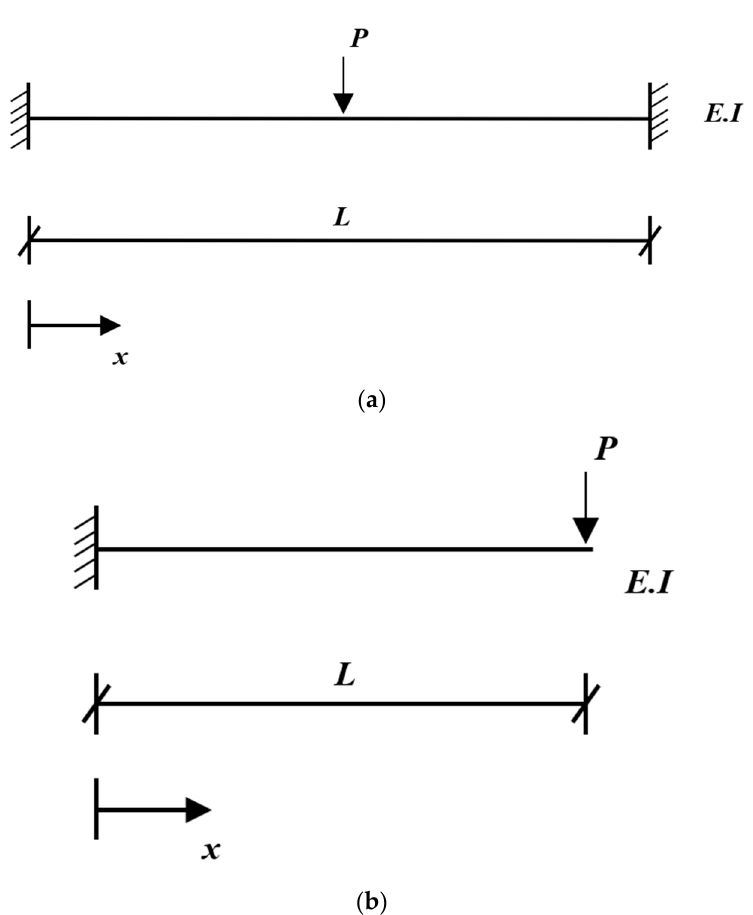
Figure 2. Elastic deflection curve: ( a ) both-end-fixed beam; ( b ) cantilevered beam.